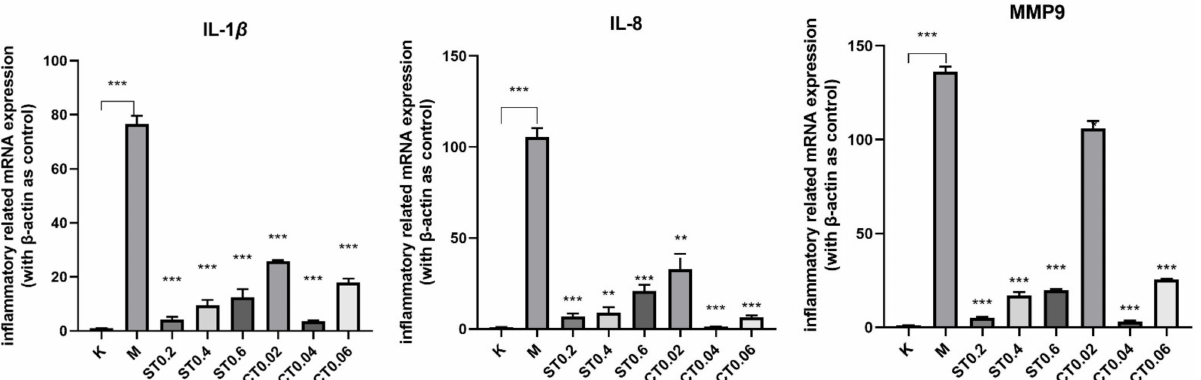
Figure 4. mRNA expression results of IL-1 β , IL-8, MMP9 in the blank group, model group, and administration group. Compared with model group, ** p < 0.01, *** p <